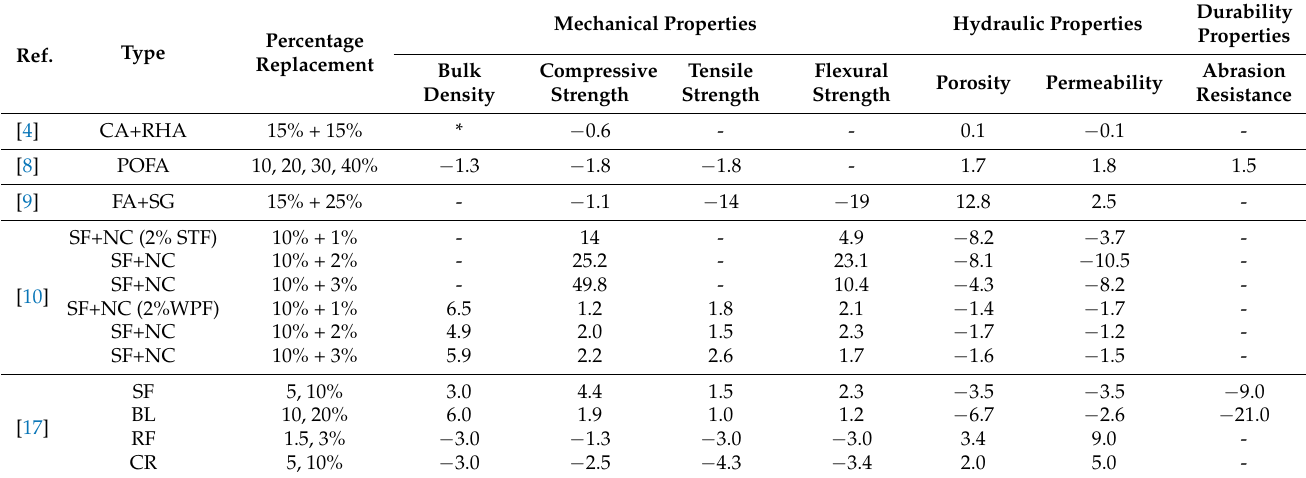
Table 1. Effect size for PC performance based on cement